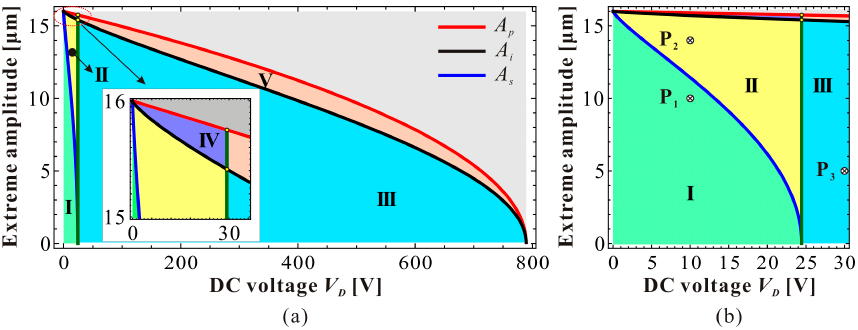
Figure 11. A dimensional zoning diagram depicting the extreme amplitude versus DC voltage. ( a ) Global view; ( b ) local view.